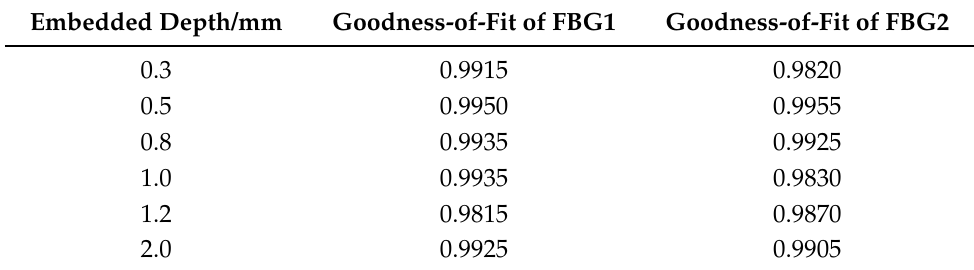
Table 2. Fitting parameters table.